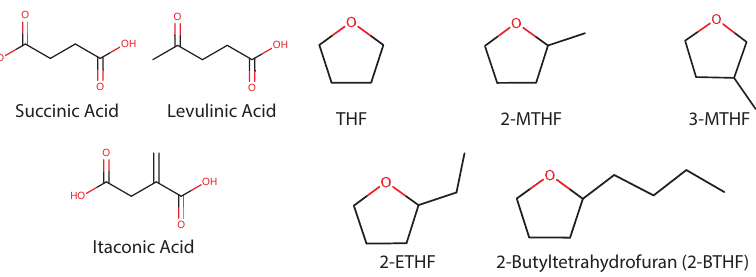
Figure 4. Chemical structures of starting platforms and resulting fuels for THF and select alkyl THFs. 2-ETHF,